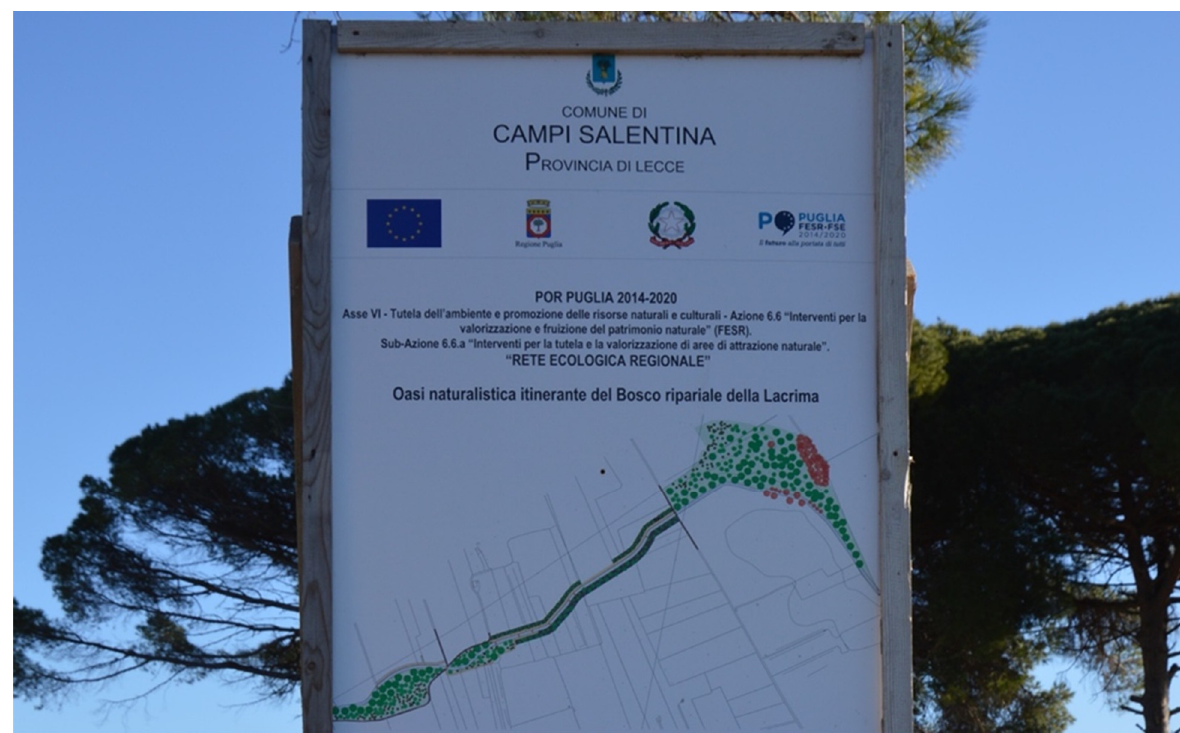
Figure 10. The signage with the masterplan of the project “The Unknown Past And Aware Future Of The Landscape Mosaic Of the Lacrima River: A Project For the Ecological Restoration Of The Riparian Forest” with the indication of Puglia Regional Operational Program 2014–2020 that financed the project.